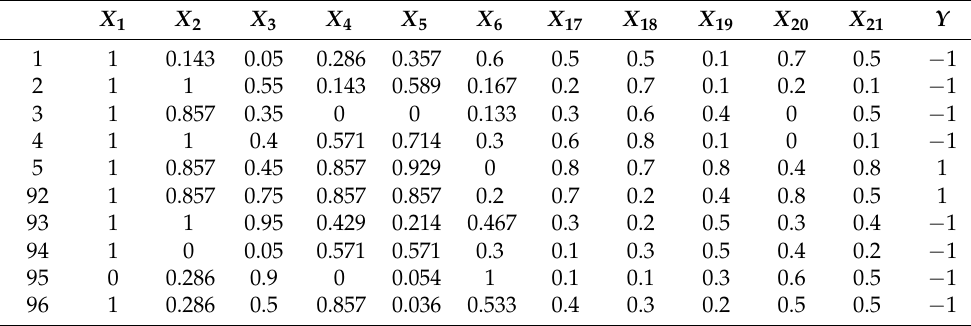
Table 2. Sample data of all users.